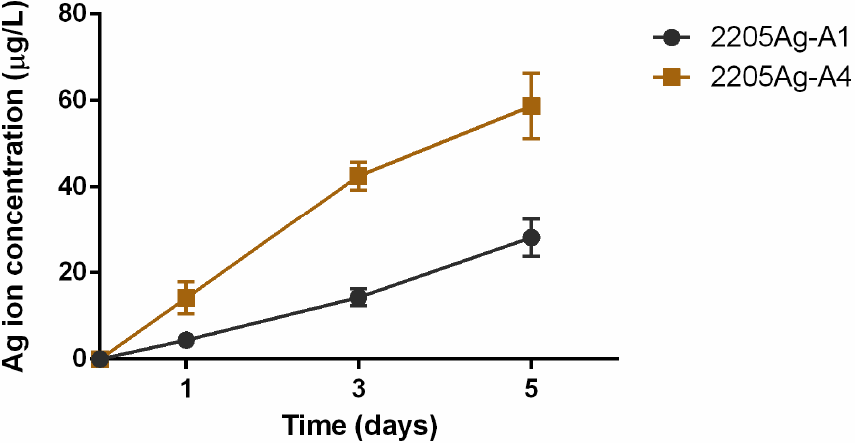
Figure 6. Effects of time on Ag ion release from 2205Ag specimens after immersion in Dulbecco’s modified Eagle medium (DMEM) for 1, 3, and 5 days.